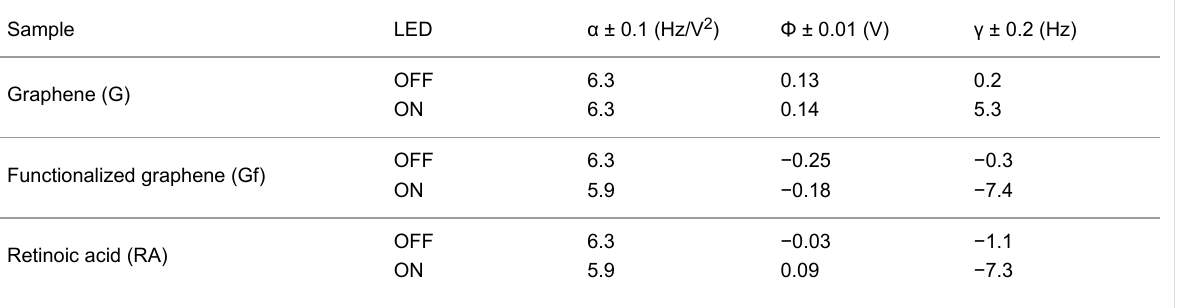
Table 1: Fitting parameters of Equation 2 for the experimental data in Figure 4c–e. The error values from the fitting analysis are shown in the first line of the table.